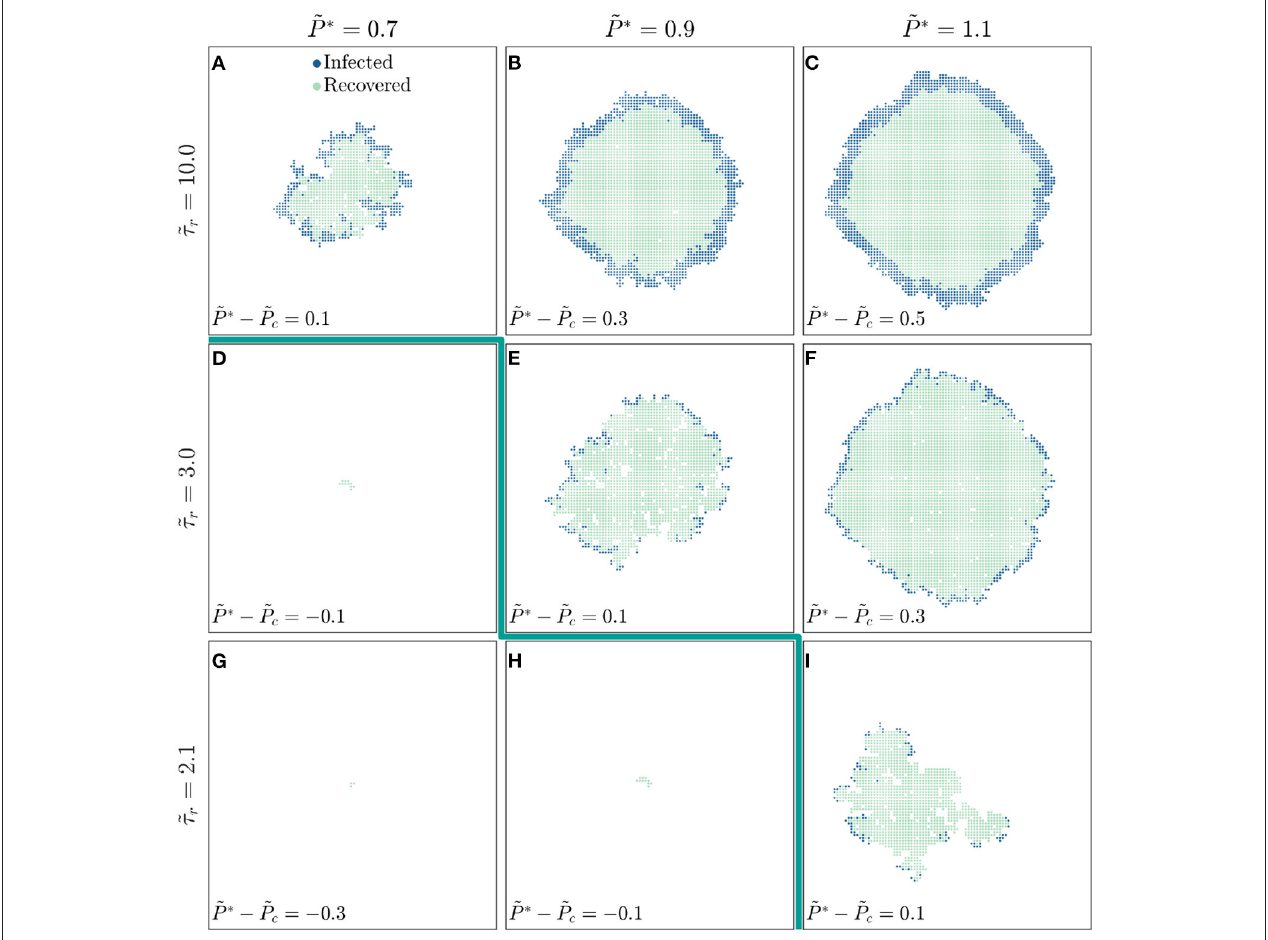
FIGURE 2 | The competition between infection and recovery determines the onset and pattern of disease spreading. For a population with a longer recovery duration τ r 10.0, (A) a disease with lower infectivity ˜ P ∗ 0.7 spreads in a ramified pattern, while diseases with higher infectivities ˜ P ∗ ˜ = = compact manner. The leading front of the infected population is trailed by an inner region of recovery, leading to the formation of a circular traveling pulse of infection. τ r For a shorter recovery duration of 3.0, (D,E) the threshold infectivity for appreciable disease spreading is larger, and (E,F) the pulse of infection is thinner. These ˜ = τ r effects are even more pronounced for the shortest recovery duration of 2.1, as shown in (G–I) . The thick green line indicates the transition to infection percolation. ˜ = τ All images are shown for the same time 75 and all data are for a uniform distribution of individual interaction barriers ˜ P th, ij ˜ = τ r influences disease network structure of the ˜ P th, ij throughout, thus demonstrating how varying ˜ P ∗ and ˜